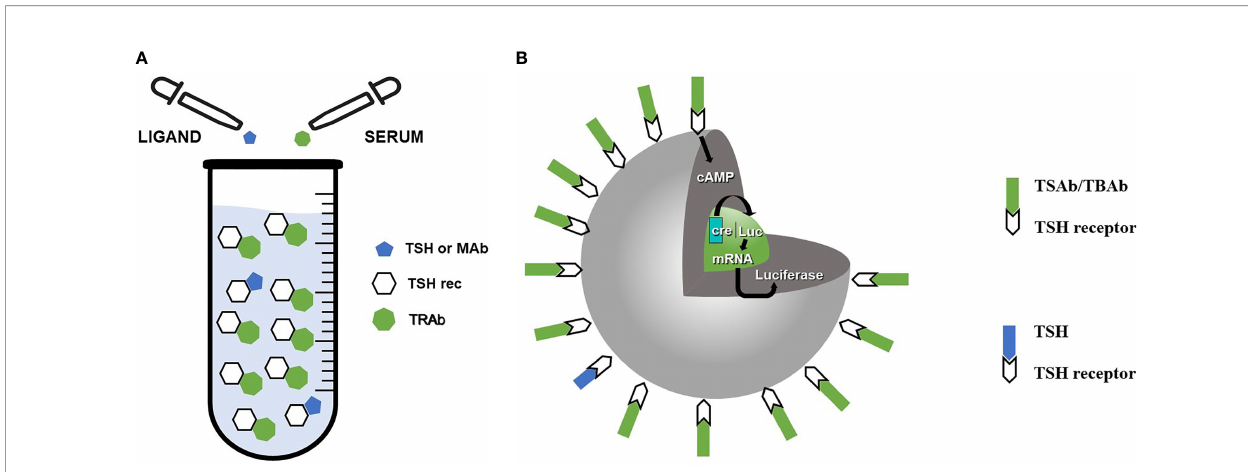
FIGURE 1 | Different methods of TSHrAb assay. (A) Assays employing competition by TRAb for binding of a ligand (TSH or monoclonal antibody) to the TSHR. (B) Bioassays involving cultured thyroid cells or nonthyroidal cells expressing the TSH receptor. Binding of TSAb or TBAb modulate cAMP production. In the depicted assay cell lines lacking TSHR are double transfected with a luciferase reporter gene under the transcriptional control of cAMP-responsive elements (CRE-Luc) and the TSH receptor. TSAb/TBAb levels in patient sera are determined by measuring the production of